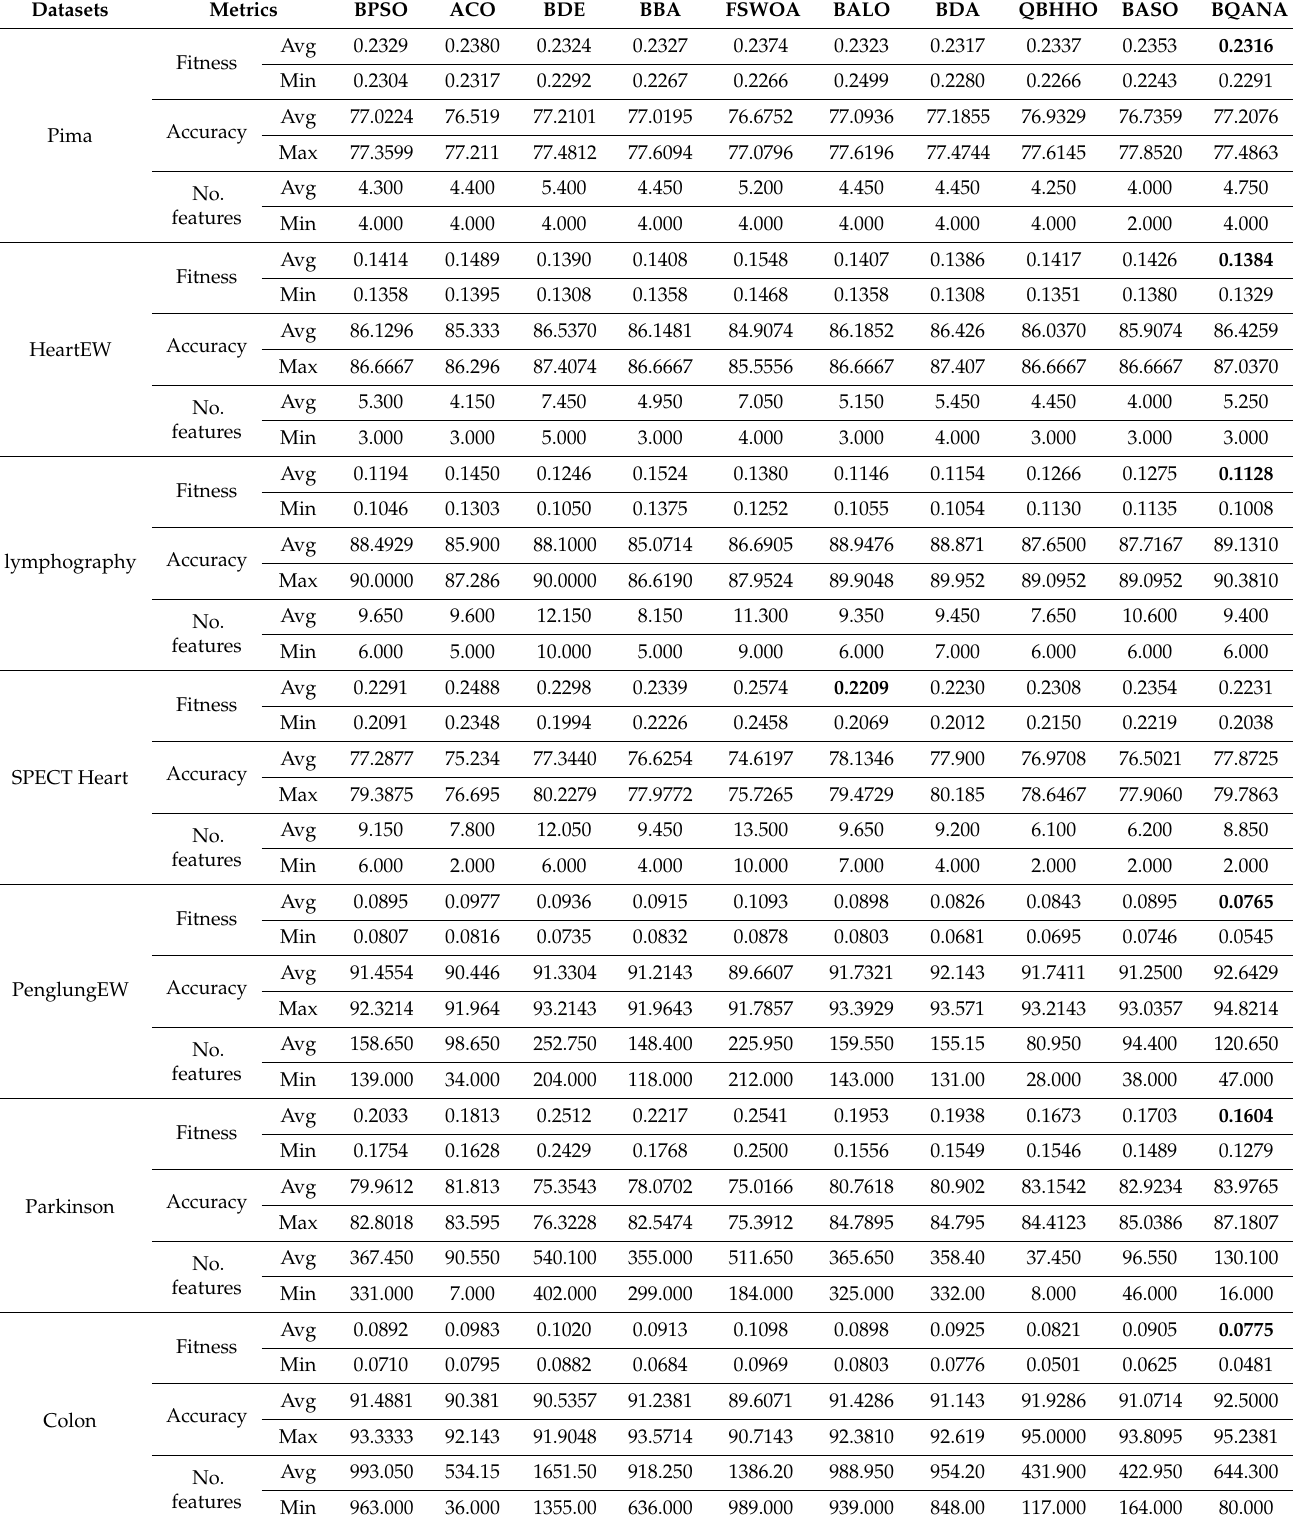
Table 6. The comparison between the BQANA and comparative